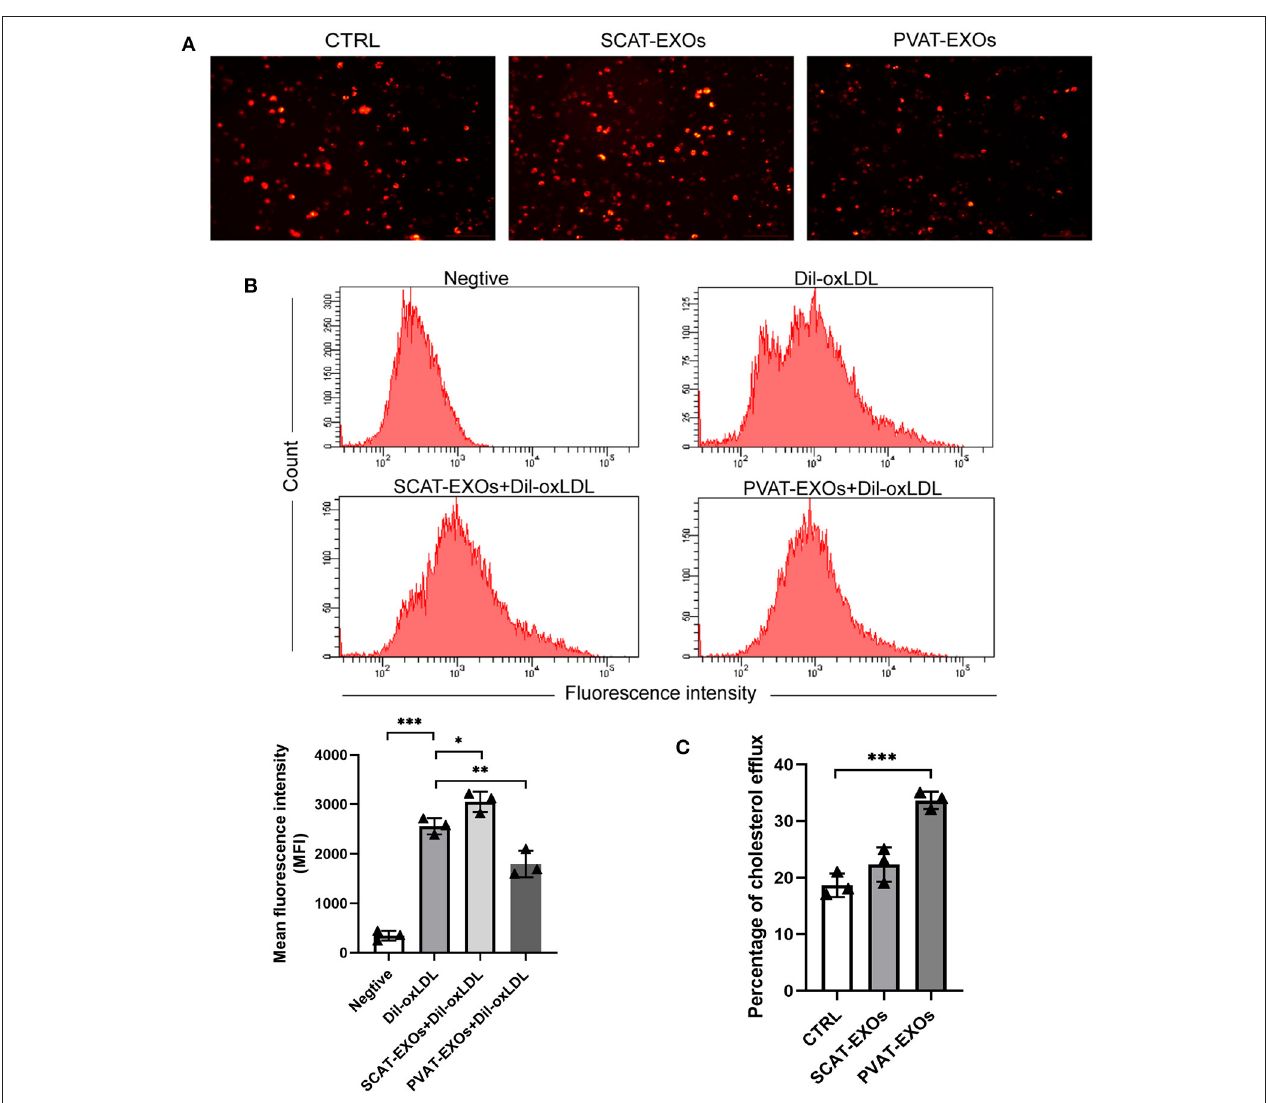
FIGURE 5 | PVAT-EXOs reduced Dil-oxLDL uptake and promote cholesterol efflux in macrophages. After treatment with SCAT-EXOs, PVAT-EXOs or PBS, Dil-oxLDL uptake by RAW264.7 cells was analysed by fluorescence microscopy (A) . In addition, the fluorescence intensities were quantified by flow cytometry (B) . HDL-mediated cholesterol efflux was significantly promoted by PVAT-EXOs (C) . Ctrl: control group. * P < 0.05, ** P < 0.01, *** P < 0.001 vs. the Dil-oxLDL group or control